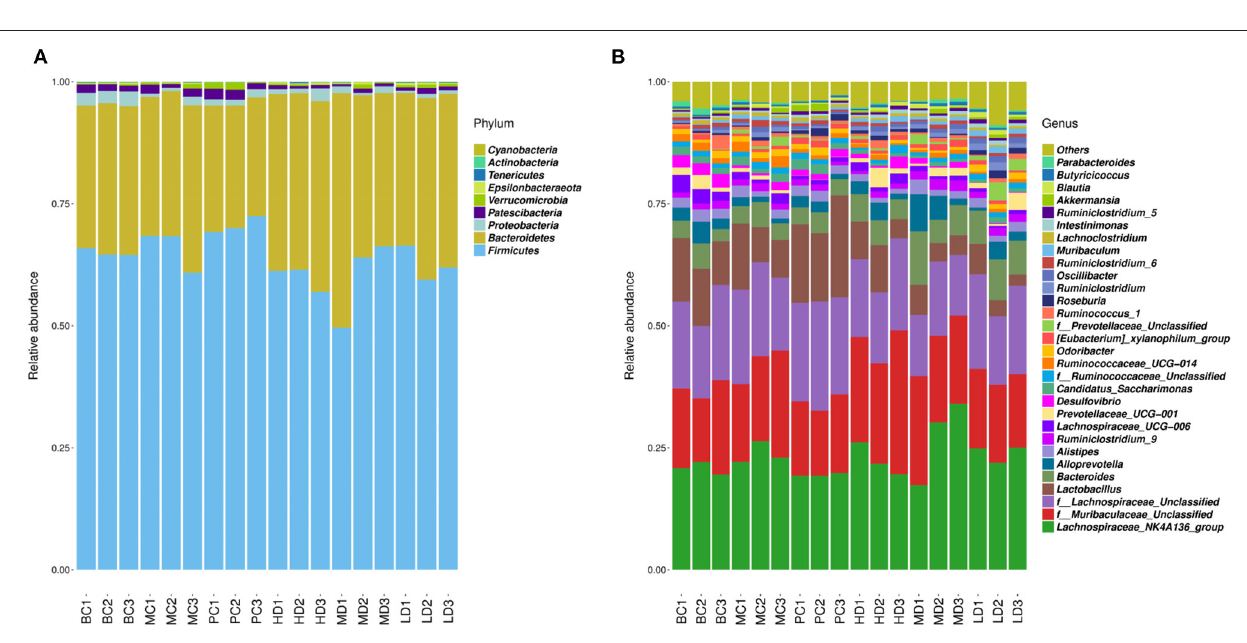
FIGURE 8 | Relative abundance of dominant groups at phylum (A) and genus (B)